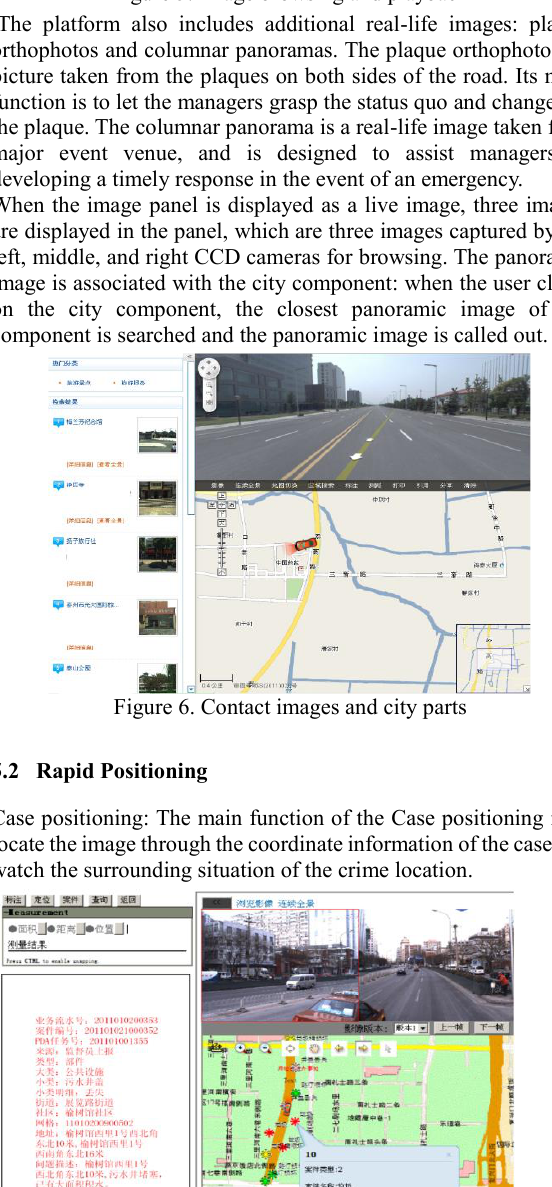
Figure 5. Image browsing and playback